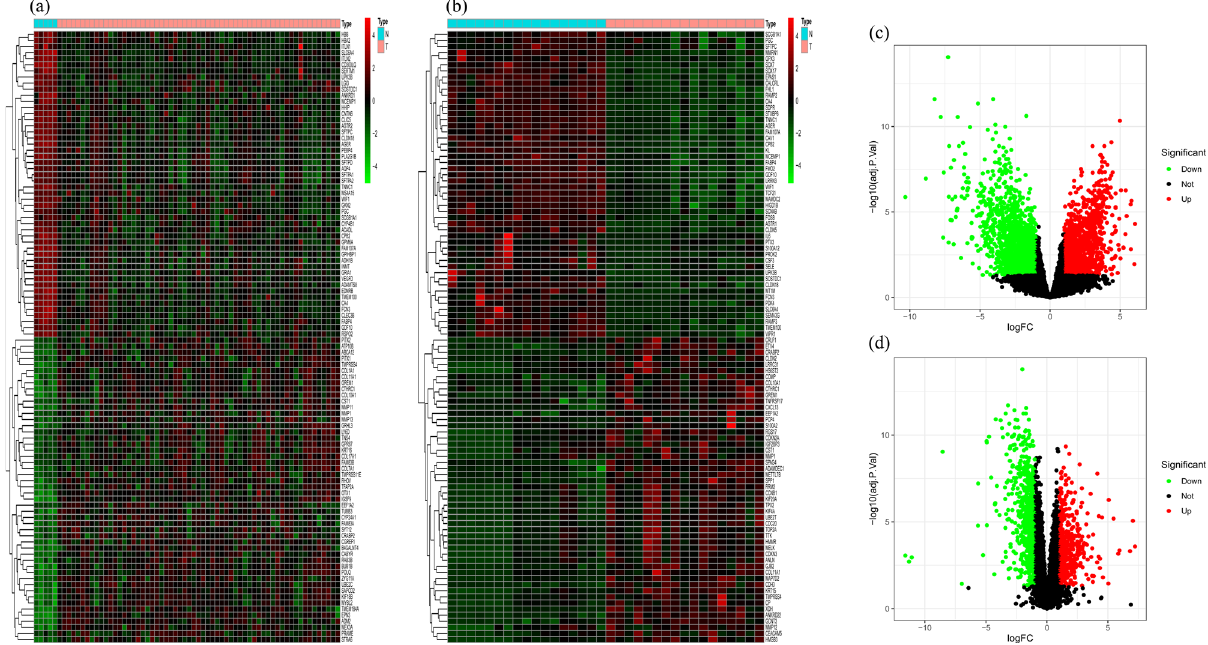
Figure 1: TOP50 di ff erential expression genes in TCGA and GEO